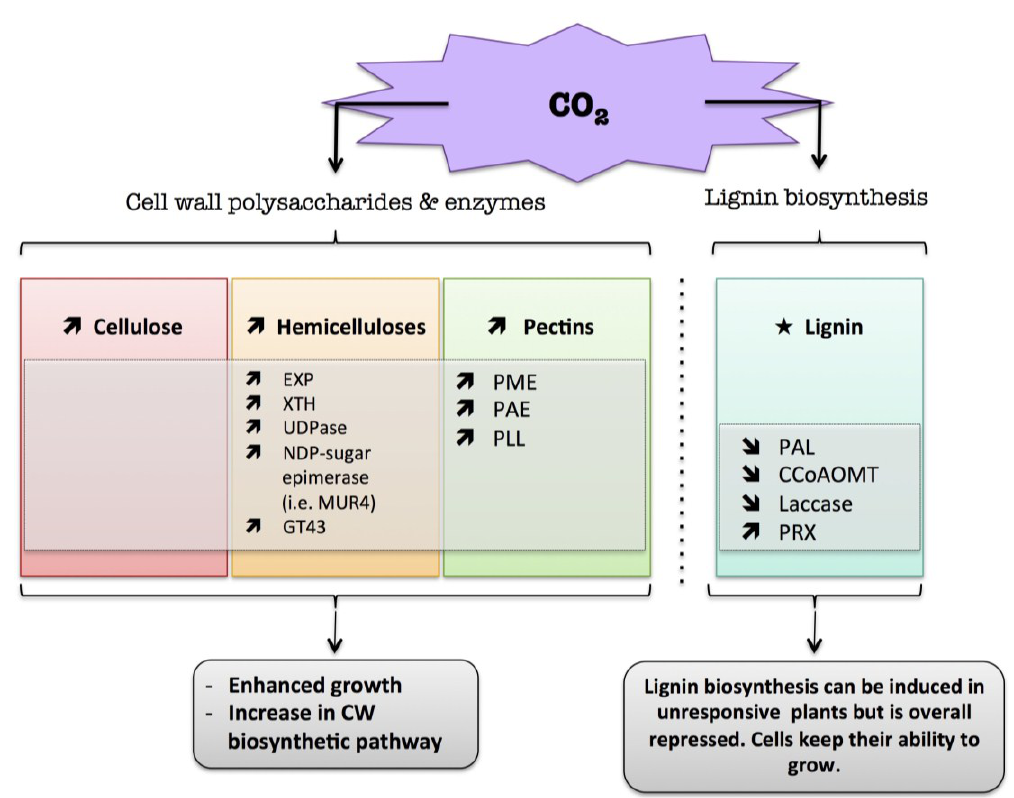
Figure 9. Diagram summarizing the plant cell wall response to elevated CO 2 . The schematic presentation is deduced from the results of different studies reported in the